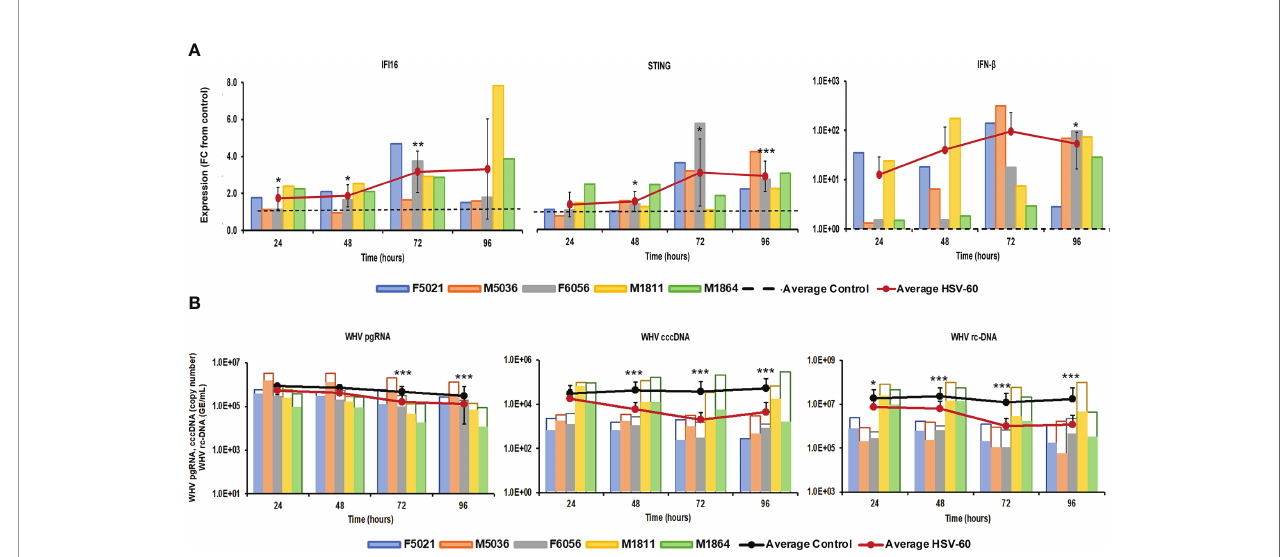
FIGURE 1 | Agonistic activation of IFI16 receptor pathway mediates WHV suppression. PWHs generated from the liver of fi ve woodchucks with CHB were treated with HSV-60 at T0 and again at 48 hours. (A) The fold-changes in transcript level of IFI16, STING, and IFN- b over 96 hours are shown, when compared to their transcript level in untreated control PWHs from individual animals at each timepoint, which was set at 1.0 and is indicated by the dotted line. (B) The changes in WHV replication (pgRNA and cccDNA) and secretion (rc-DNA) during treatment are presented for untreated control (empty bars) and HSV-60 treated PWHs (colored bars) from individual animals at each timepoint. The average fold-change in gene transcript level or average change in WHV load of control and HSV-60-treated PWHs are presented as solid lines. Horizontal bars represent the standard error of the mean. P values representing statistical signi fi cance from untreated control PWHs are shown as * for <0.05, ** for <0.01, and *** for <0.001. FC,